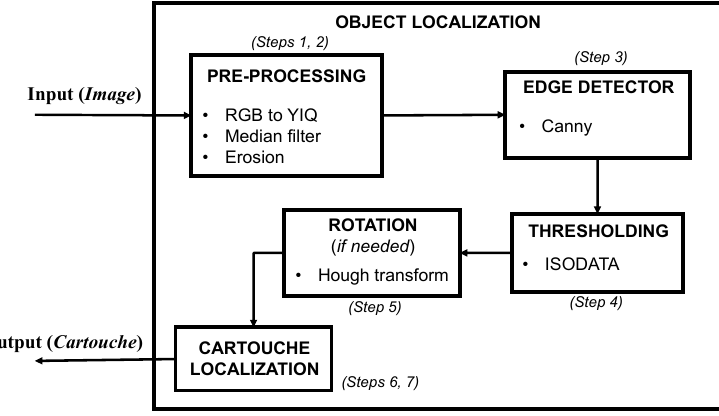
Figure 7. Scheme of the object localization process.